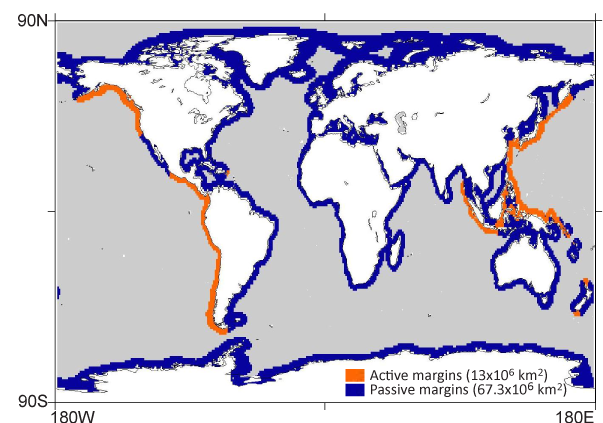
Fig. B1. Global map indicating margins and deep sea areas. The distinction between active (orange) and passive (light blue) margins is based on Archer et al. (2009). The total areas for active and passive margins calculated in a 1 × 1 ◦ basis are shown for